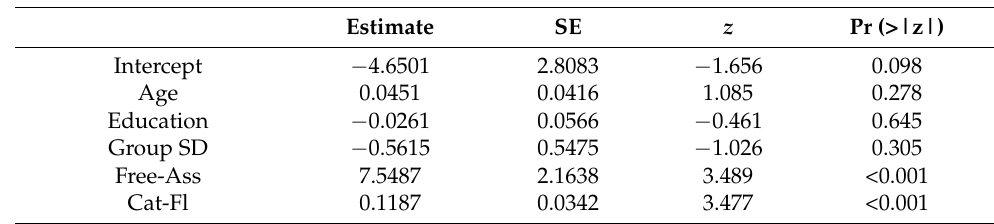
Table 5. Coefficients for mixed effects model examining PN, taking multiple predictors simultane- ously into